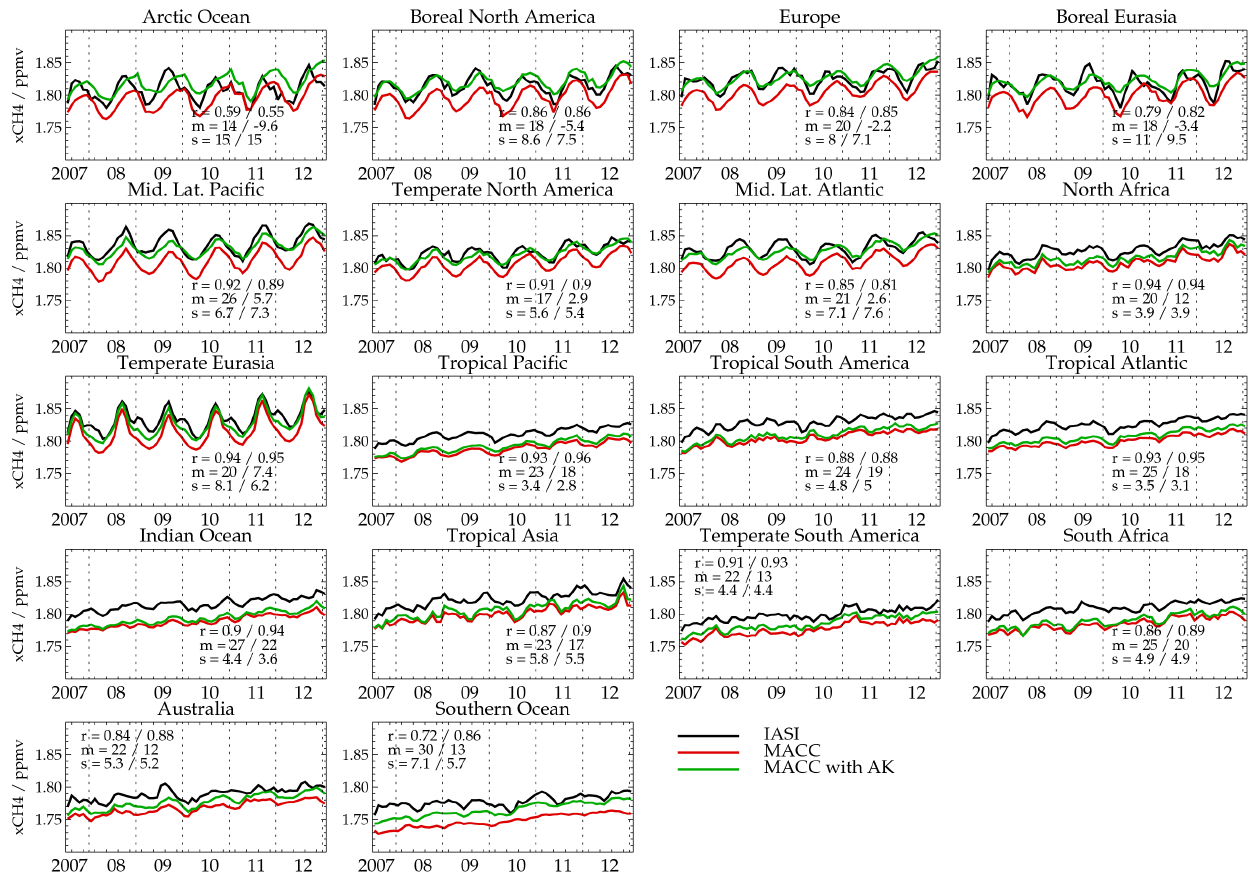
Figure 12. As previous figure but for 6–12km layer-averaged